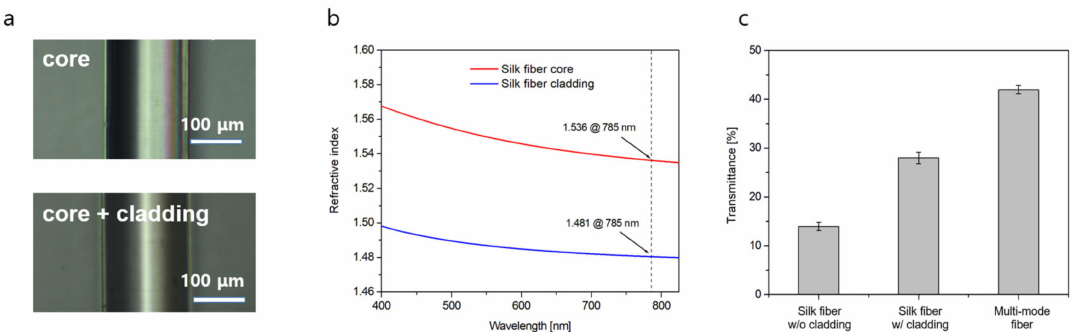
Figure 2. Characteristics of the silk fiber-optic probe. ( a ) The outer diameter of the silk core and cladding layers. ( b ) Refractive index measure for core and cladding structures made of silk fibroin proteins. The dotted line at λ = 785 nm indicates the condition for the SERS experiment. ( c ) Optical transmittance test results for silk fibers with and without a cladding layer and multi-mode fibers. The fiber length was fixed at 3